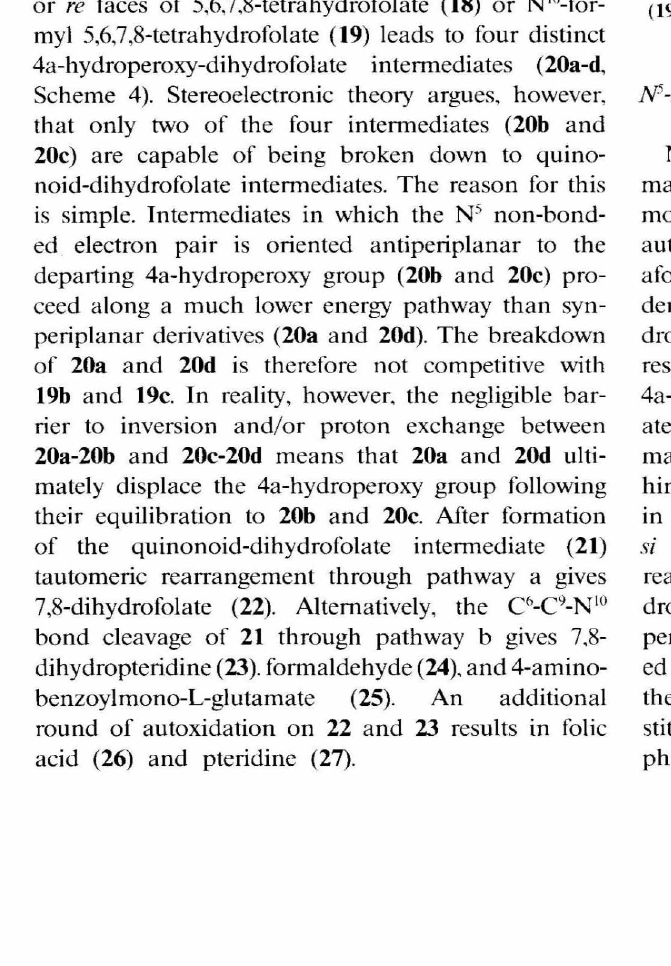
Scheme 3. Hypothetical autoxidation pathway of 7,8-dihydro folic acid